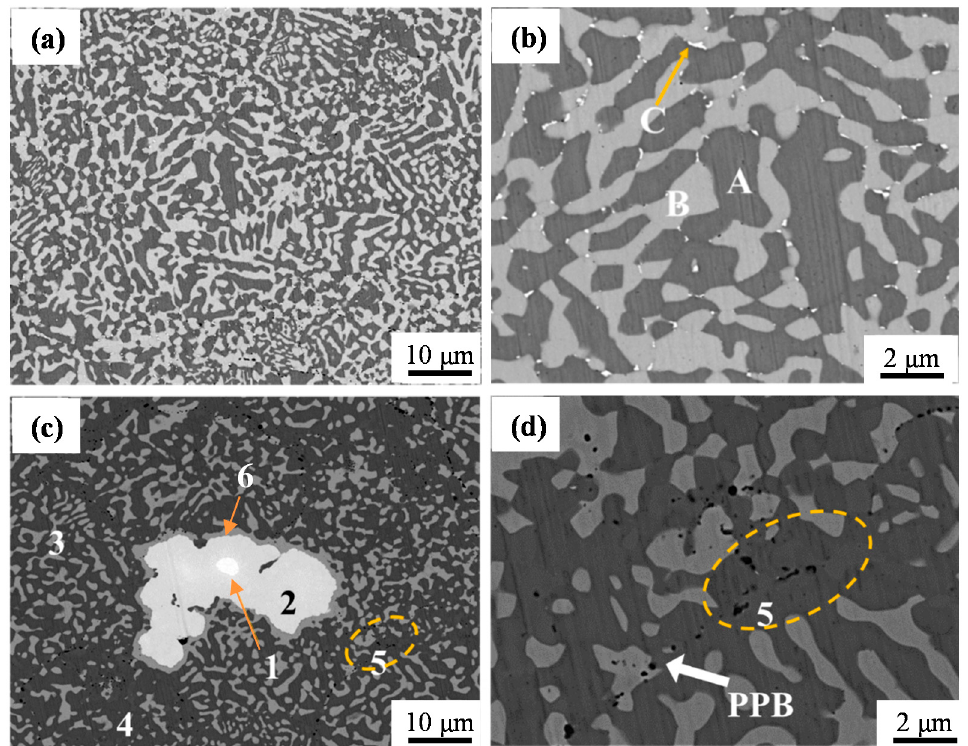
Figure 4. Backscattered electron images of the Co–Cr–W alloy and the Co–Cr–W matrix composites. ( a , b ) Co–Cr–W alloy; ( c , d ) Co–Cr–W matrix composites.